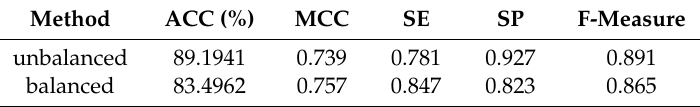
Table 5. The result of using different feature representation methods.